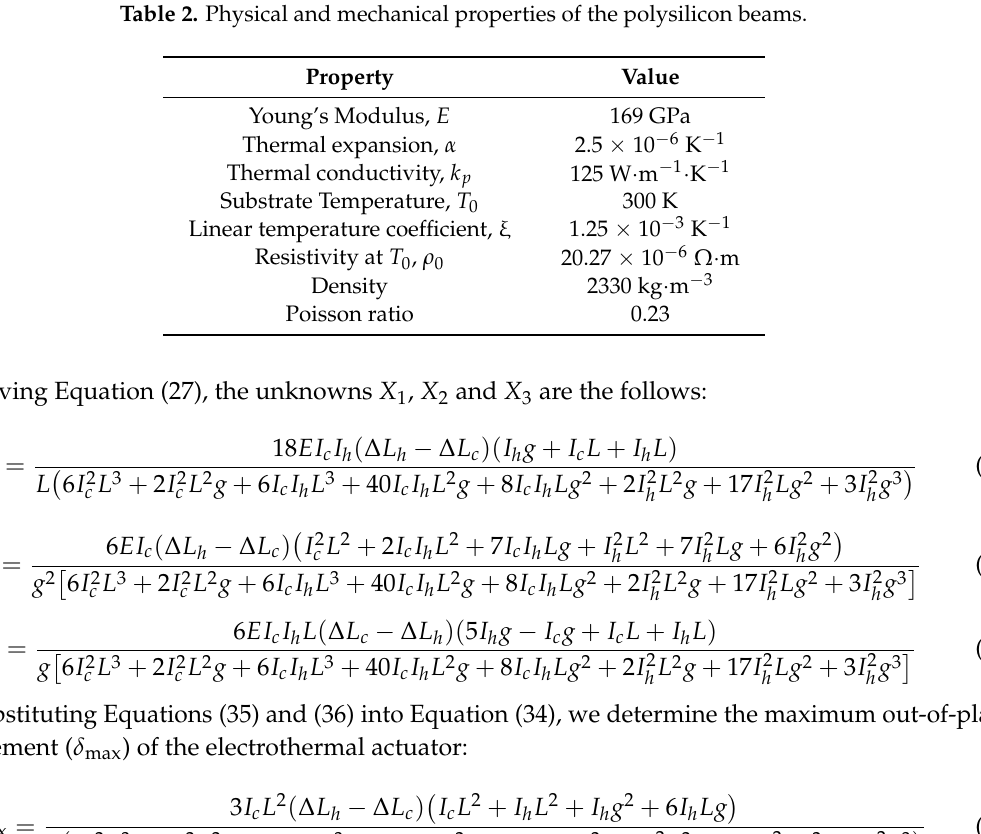
Table 2. Physical and mechanical properties of the polysilicon